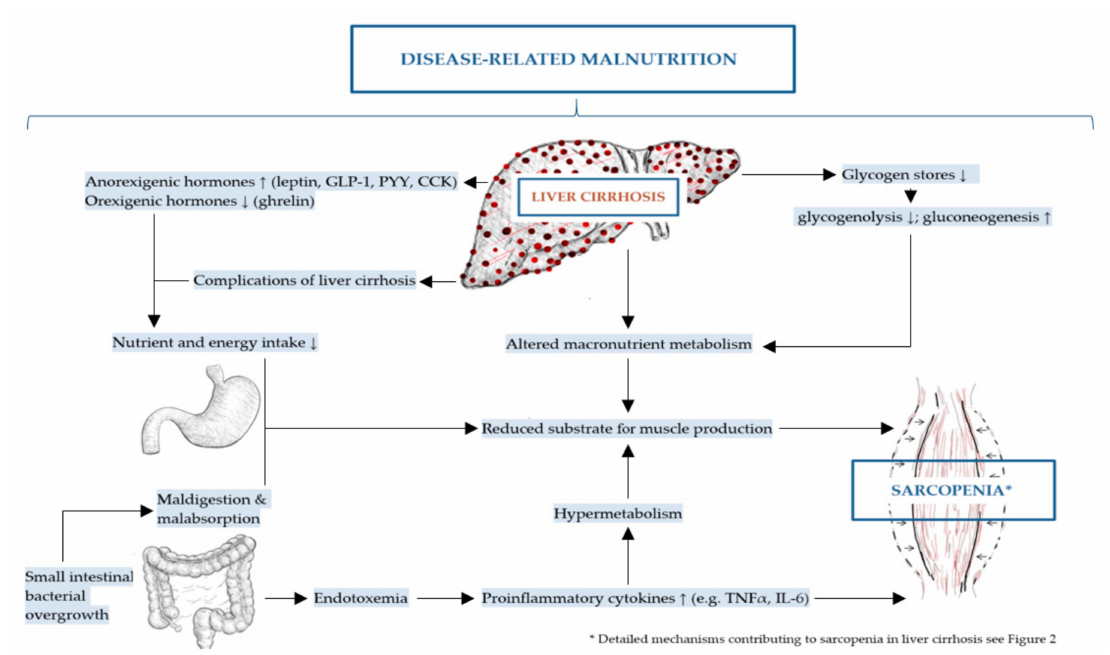
Figure 1. Mechanisms contributing to disease-related malnutrition (DRM) and sarcopenia in liver